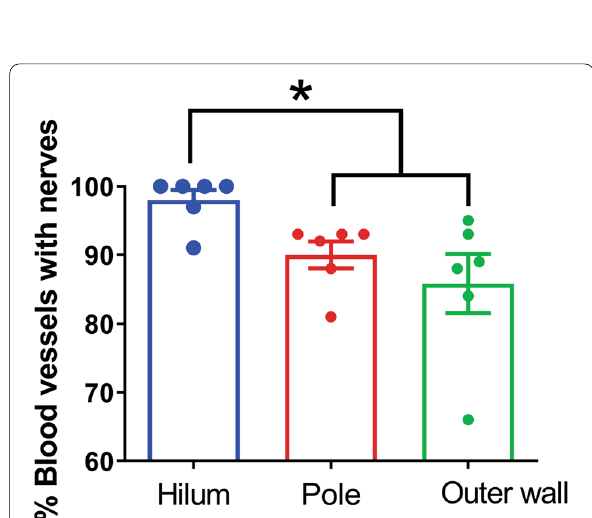
Fig. 3 Quantification of blood vessel innervation in three regions of human spleen. Values are the mean significant difference from all other groups ( P measures analysis of variance; Tukey’s multiple comparison